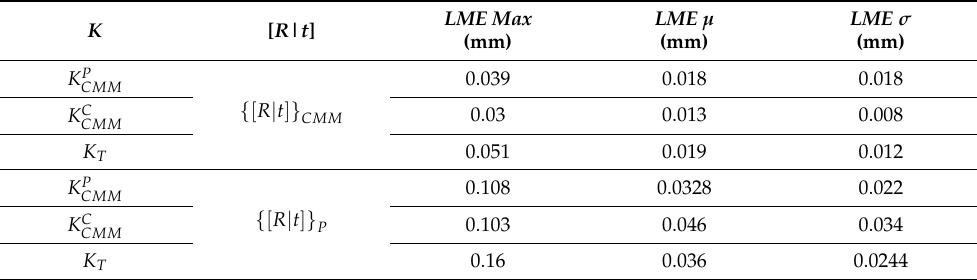
Table 4. LME maximum, average and standard deviation (k = 1) through VDI guideline for each calibration combination.